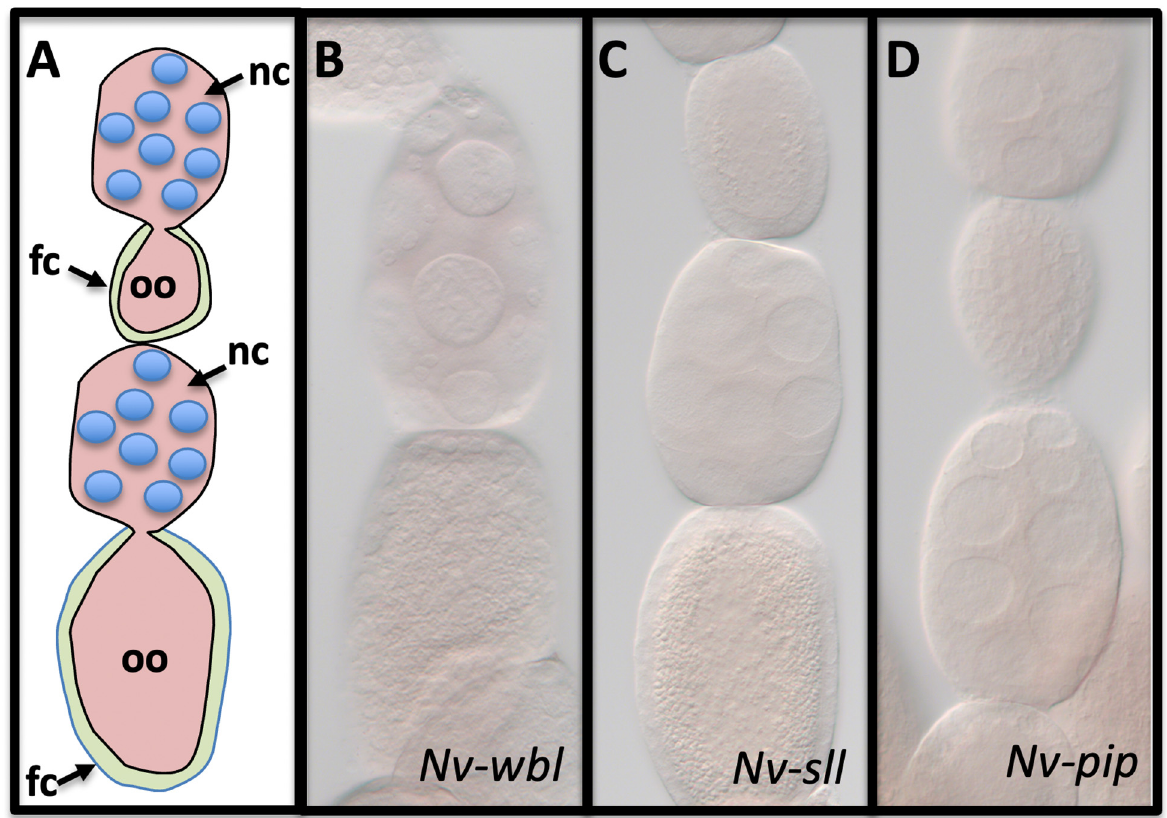
Figure 2. Expression of vitelline membrane altering components. ( A ) Schematic drawing of two N. vitripennis egg chambers. fc = follicle cell layer, oo = oocyte, nc = nurse cells. Somatic tissue is shown in green; pink tissue is germline. The upper egg chamber represents early oogenesis, where the oocyte is smaller than the nurse cell compartment, while the lower egg chamber represents late oogenesis. Mid-oogenesis is when the two compartments are roughly the same size. None of Nv-wbl ( B ), Nv-sll ( C ), or Nv-pip ( D ) are expressed detectably in the ovary of N. vitrpennis . Mid- and late-stage egg chamber